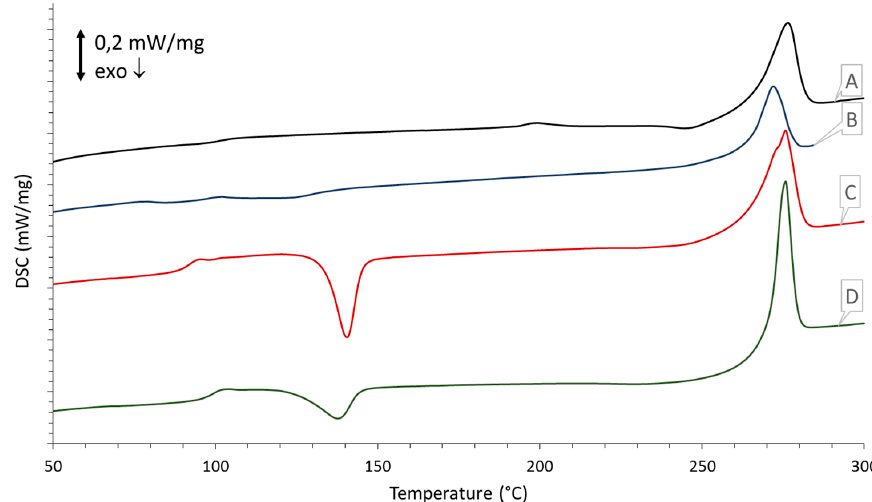
Figure 6. Thermograms representing the first heating run of the processed samples: ( A ) unprocessed; ( B ) ball milled for 15 min; ( C ) spray dried at optimal conditions; ( D ) rotor milled after final sieving step.